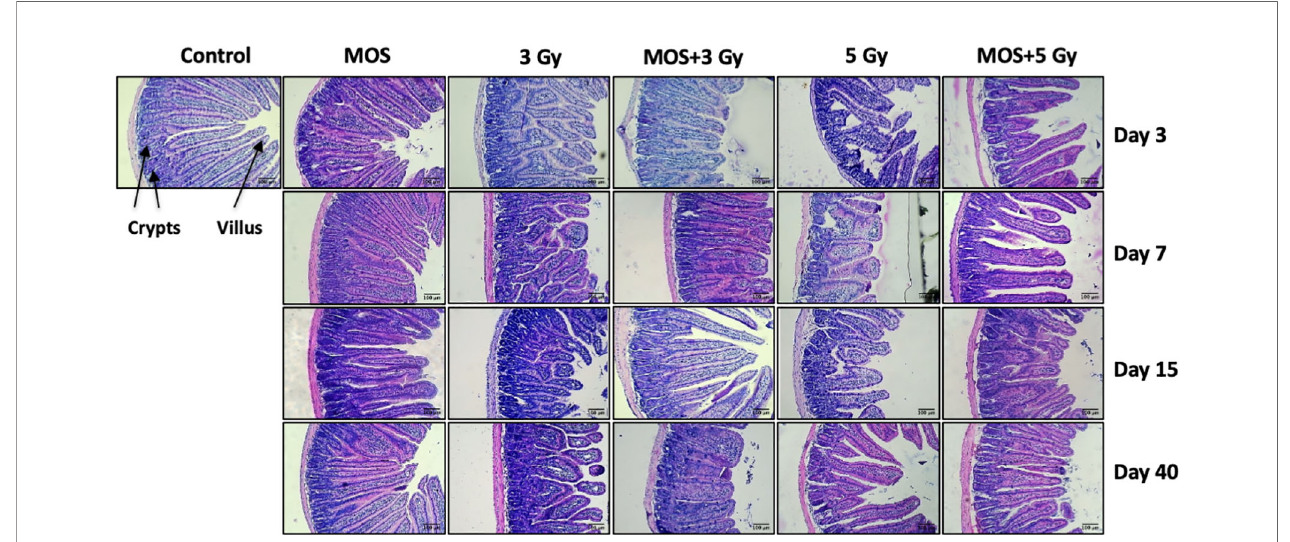
FIGURE 4 | Histological examination of small intestine. Mice were treated with MOS and/or subjected to TBI (3 and 5 Gy) and assessed for histological examination of small intestine on days 3, 7, 15, and 40-post MOS treatment and/or TBI as described in Materials and Methods . Scale bar equals 100 m m with an original magni fi cation of